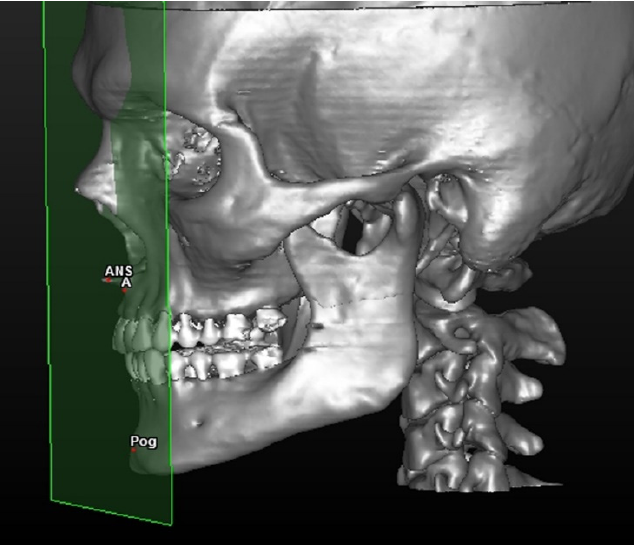
Figure 2. AFP or anterior facial plane traces anterior nasal spine and is parallel to the axial plane. The cephalometric points involved in the analysis are Point A (A) and Pogonion (Po)